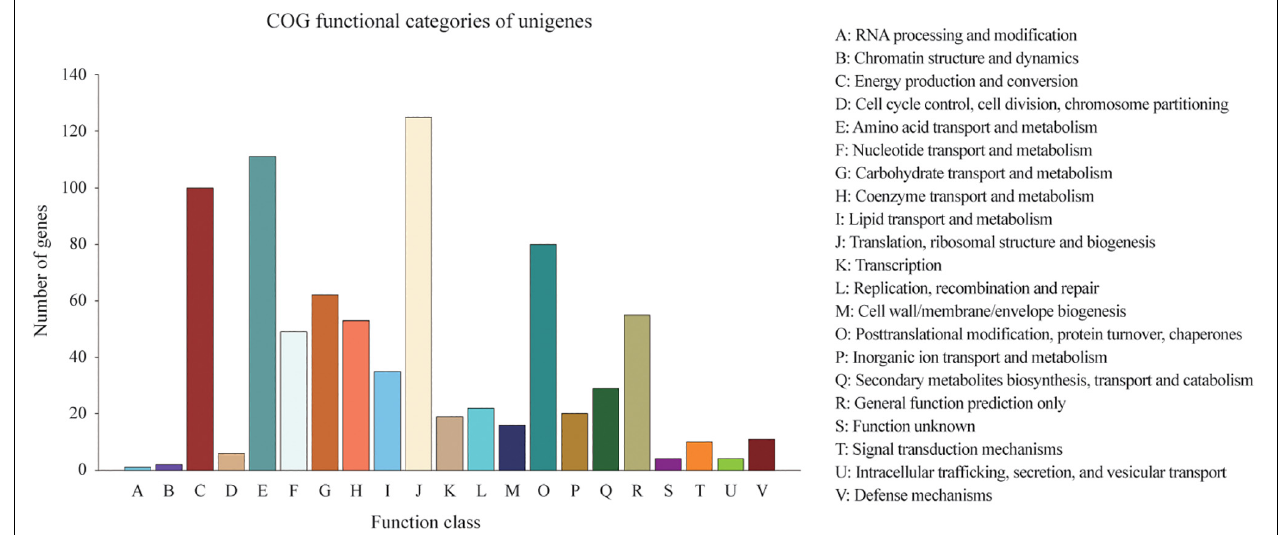
FIGURE 2 | Distribution of 727 predicted genes in C. oleophila and 21 different COG functional categories.